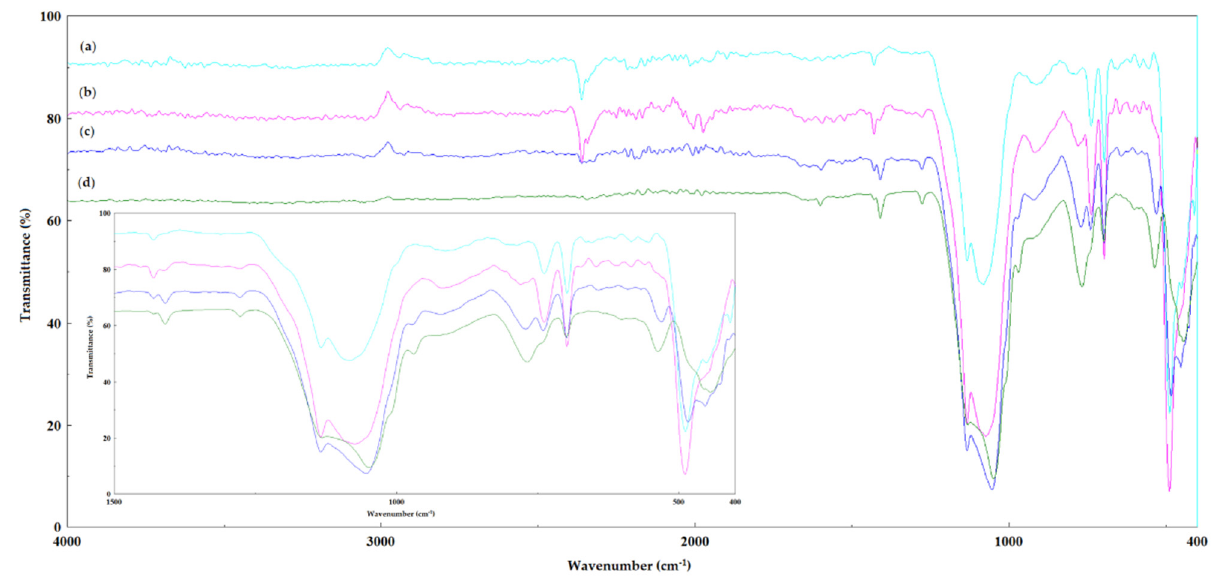
Figure 6. FT-IR spectra of cellulase immobilized biocatalysts, obtained by the sol–gel entrapment method: ( a ) SG6—PhTMOS:TMOS (1:1); ( b ) SG9—VTMOS:PhTMOS:TMOS (0.4:1.6:1); ( c ) SG10— VTMOS:PhTMOS:TMOS (1:1:1); ( d ) SG11—VTMOS:PhTMOS:TMOS (1.6:0.4:1). Inset: enlarged picture of the 400–1500 cm − 1 region.